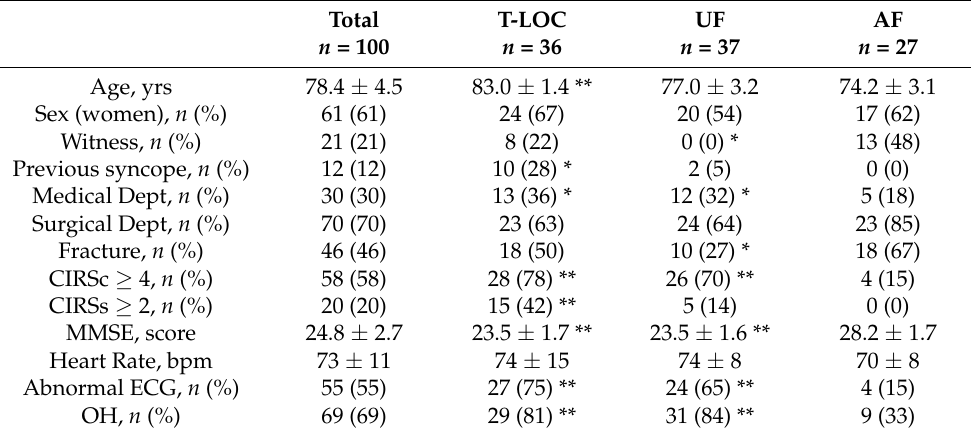
Table 1. Demographic and clinical characteristics of patients admitted to a Sub-Acute Care Unit with a diagnosis of traumatic fall.